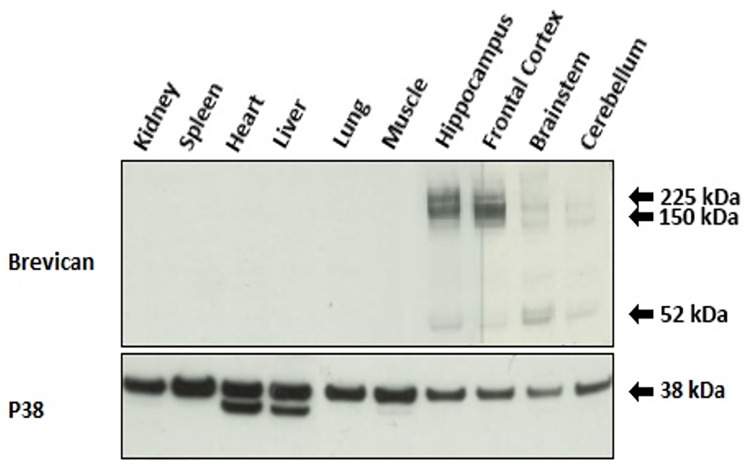
Specific localization of brevican to tissues of the CNS.A Western blot performed on homogenates of 10 different rat tissues is shown (n = 1). A commercial antibody targeting brevican visualizes protein bands around 150 to 250 kDa and a faint band around 50 kDa only in tissue of the rat CNS. The original and unadjusted images underlying this figure are presented in Supporting Information.